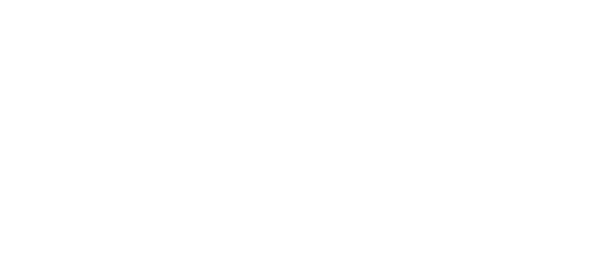
Table 3. Kinetic parameters for the adsorption of cadmium on activated hydrochar.